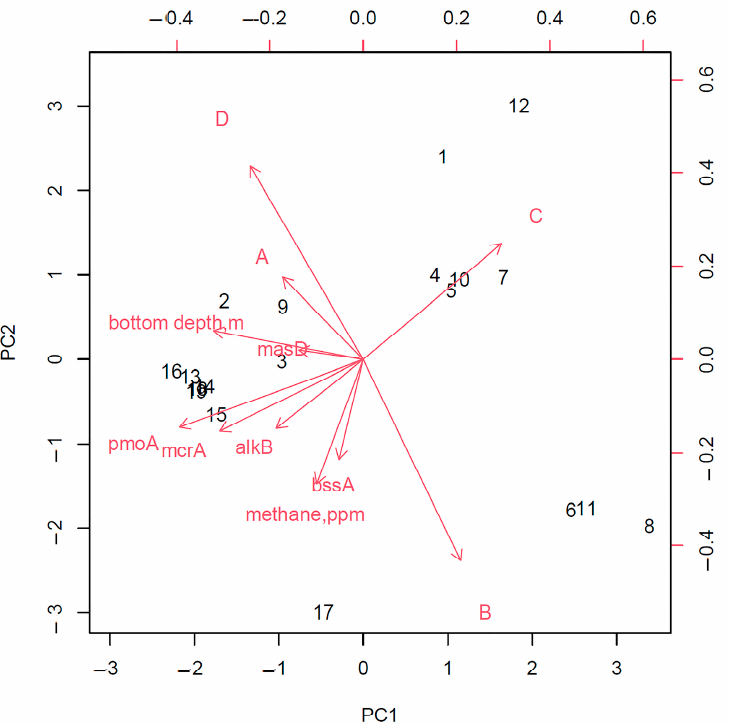
Figure 8. Relationships of the studied bioindicator signs in the gas-hydrate ( 1 ) and non-gas-hydrate ( 2 ) areas. (A) The degree of biodegradation of hydrocarbons under aerobic conditions;(B) the de- gree of biodegradation of hydrocarbons under anaerobic conditions;(C) frequency of isolation of strains;(D) frequency of isolation of strains capable of only aerobic degradation of hydrocarbons.